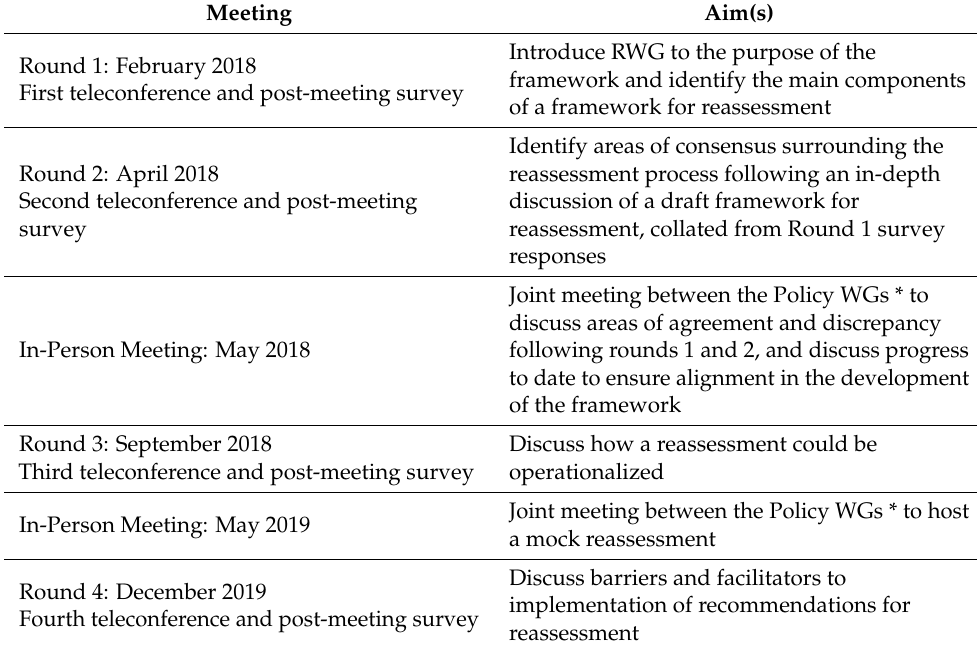
Table 1. Timeline and Specific Aims of Reassessment and Uptake Working Group (RWG) Meetings and